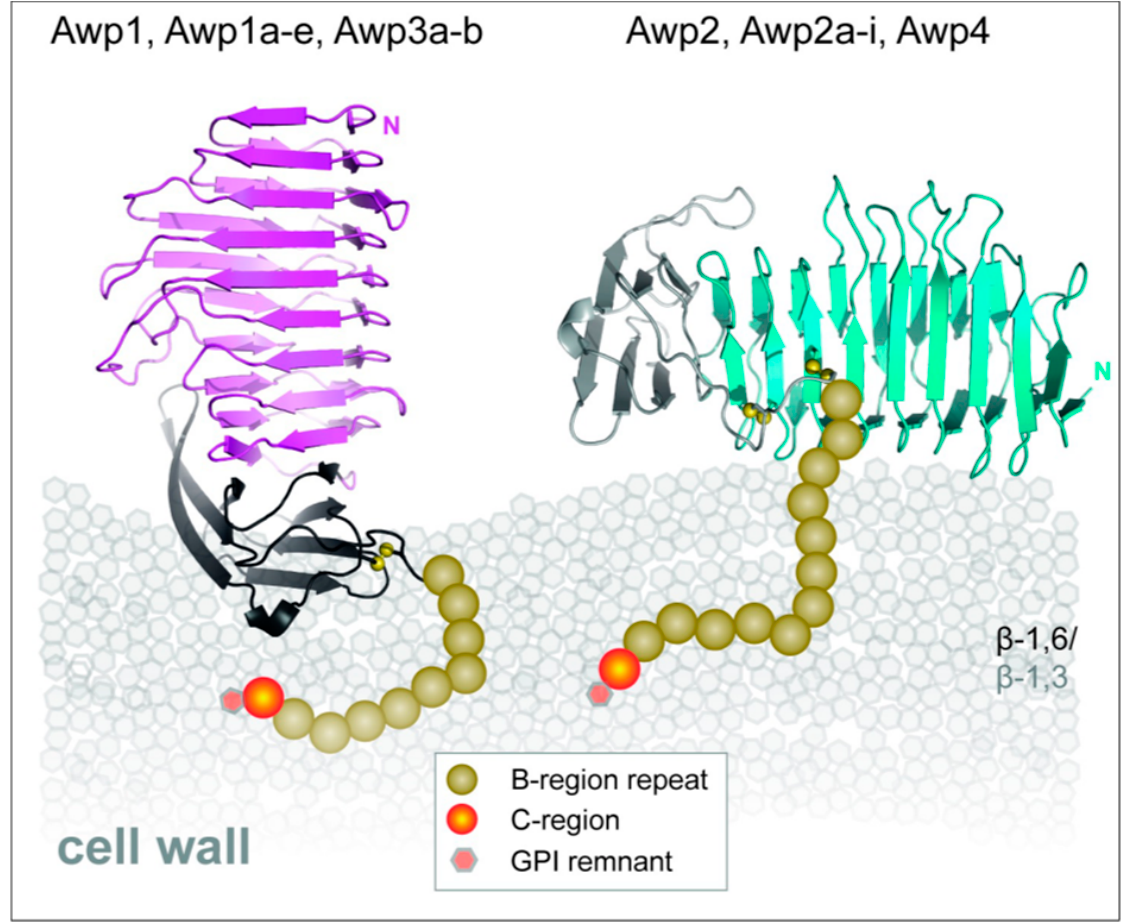
Figure 5. C. glabrata Awp adhesins. These adhesins have cylindrical β -barrel adhesive domains. Image reused with permission from [70]: 2021, Lars-Oliver Essen.